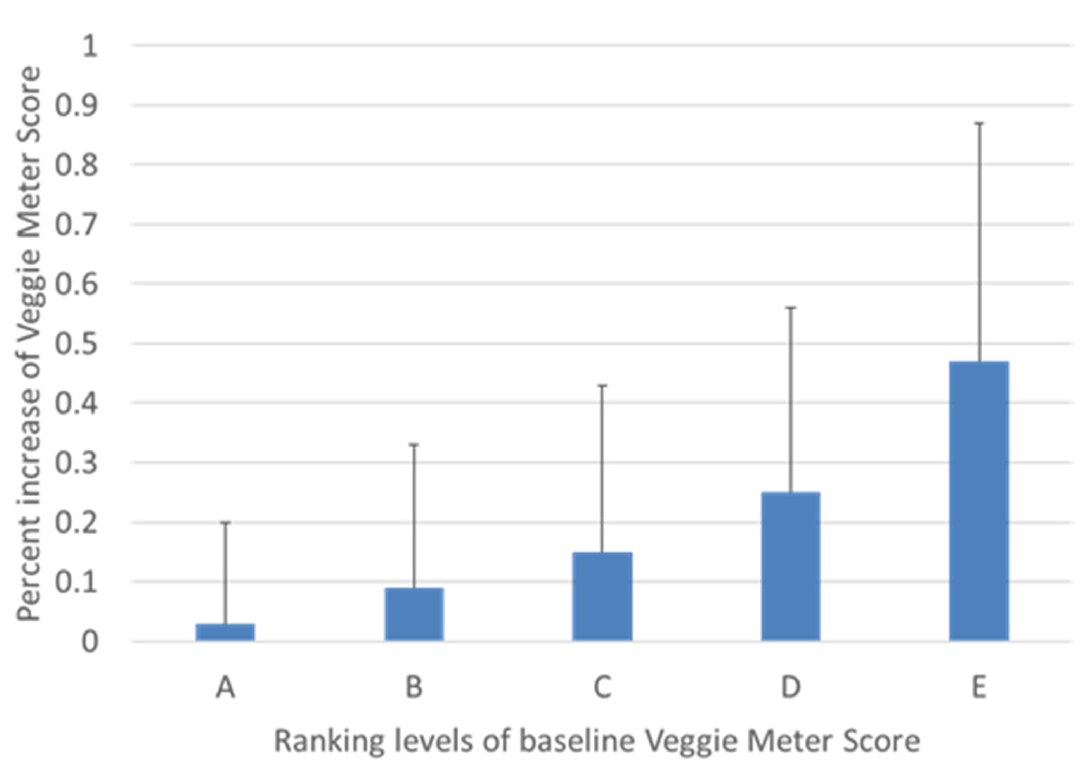
Figure 5. The percentage of increase in Veggie Meter score based on five baseline rankings. The percentage of increase in subjects with Rank D and C was significantly higher than subjects with Rank A ( p < 0.0001, one-way ANOVA, p = 0.001 and <0.0001, Bonferroni’s test). The results of dietary and habitual surveys are shown in Table 2. The VM scores for each question were statistically analyzed, and p -values are shown in Table 2.